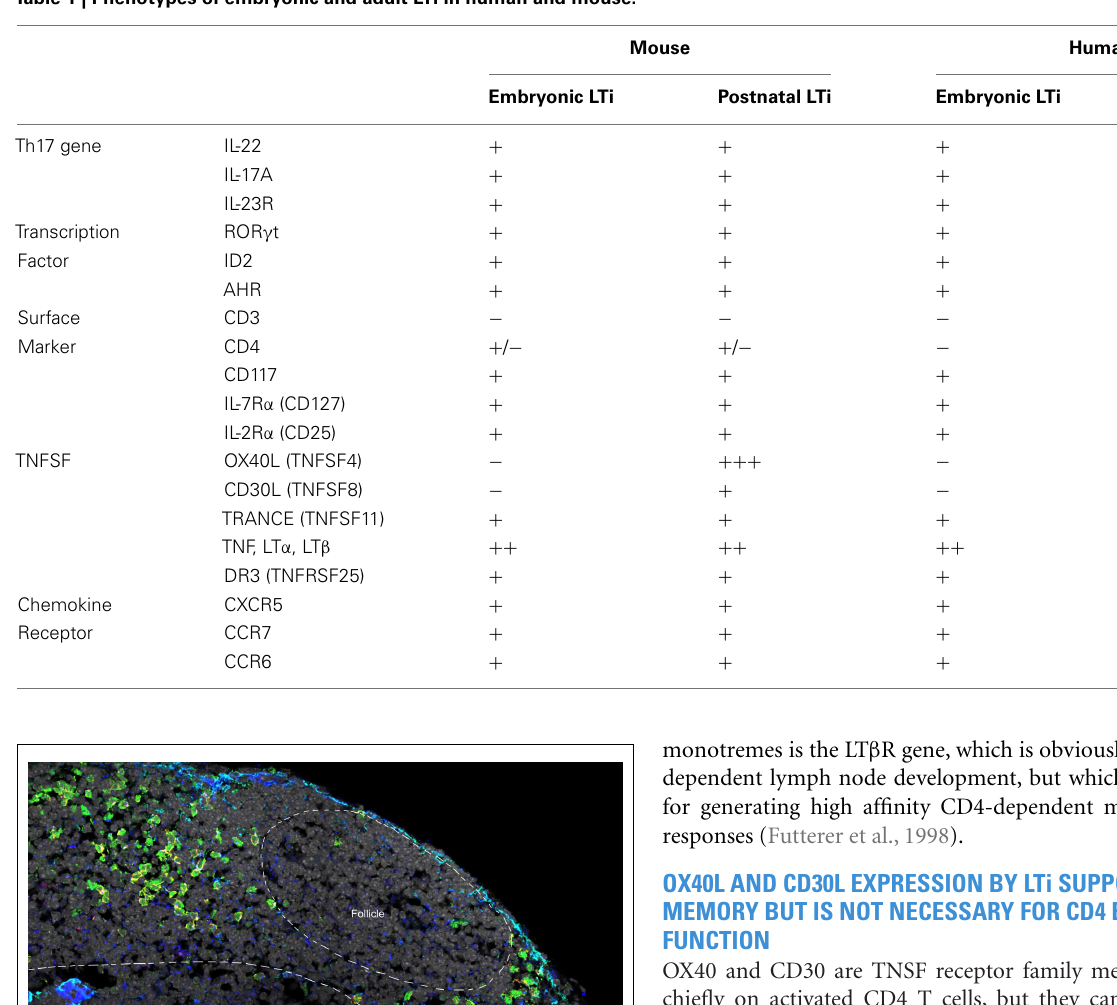
Table 1 | Phenotypes of embryonic and adult LTi in human and mouse.